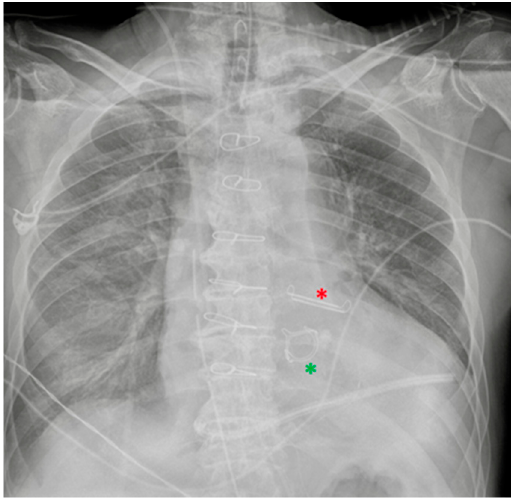
Figure 20. Left atrial appendage closure device (red asterisk). Prosthetic biological mitral valve (green asterisk). the image also shows right jugular CVC, ETT, NG-tube, chest tubes and sternal wires.